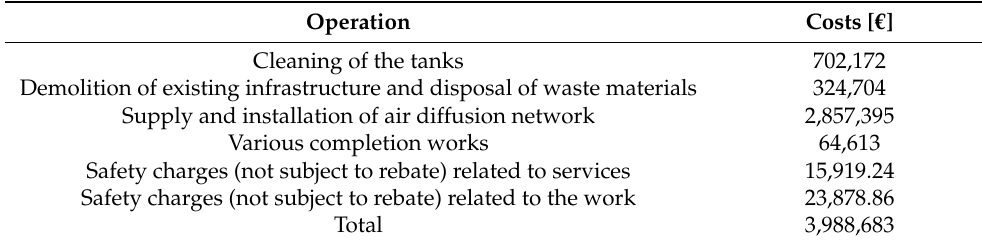
Table 3. Investment costs for the substitution of diffusers (market values).